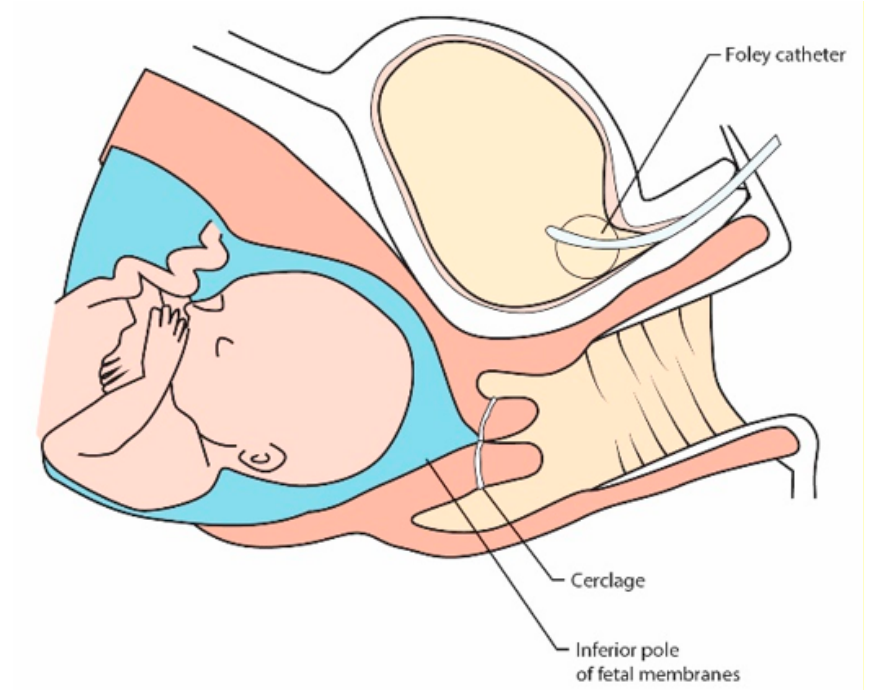
Figure 2. Filling the bladder with physiological saline in a patient positioned in the Trendelenburg position turned out to be technically effective for draining a prolapsed fetal membranes.